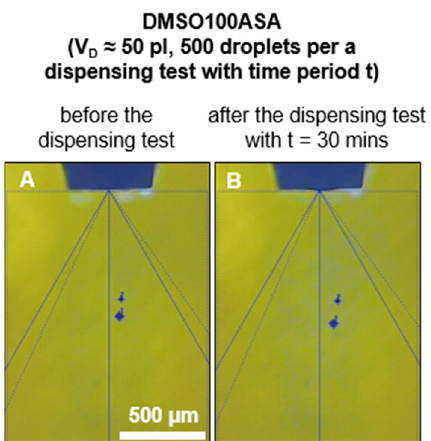
Figure 7. Droplet formation at the beginning ( A ) and end of the dispensing test with time period t = 30 min ( B ). 500 droplets of the drug solution DMSO100ASA were ejected uniformly over the time period. Despite the high drug concentration of c = 100 g/L, no drug deposits were detected even for the longest time period of t = 30 min.